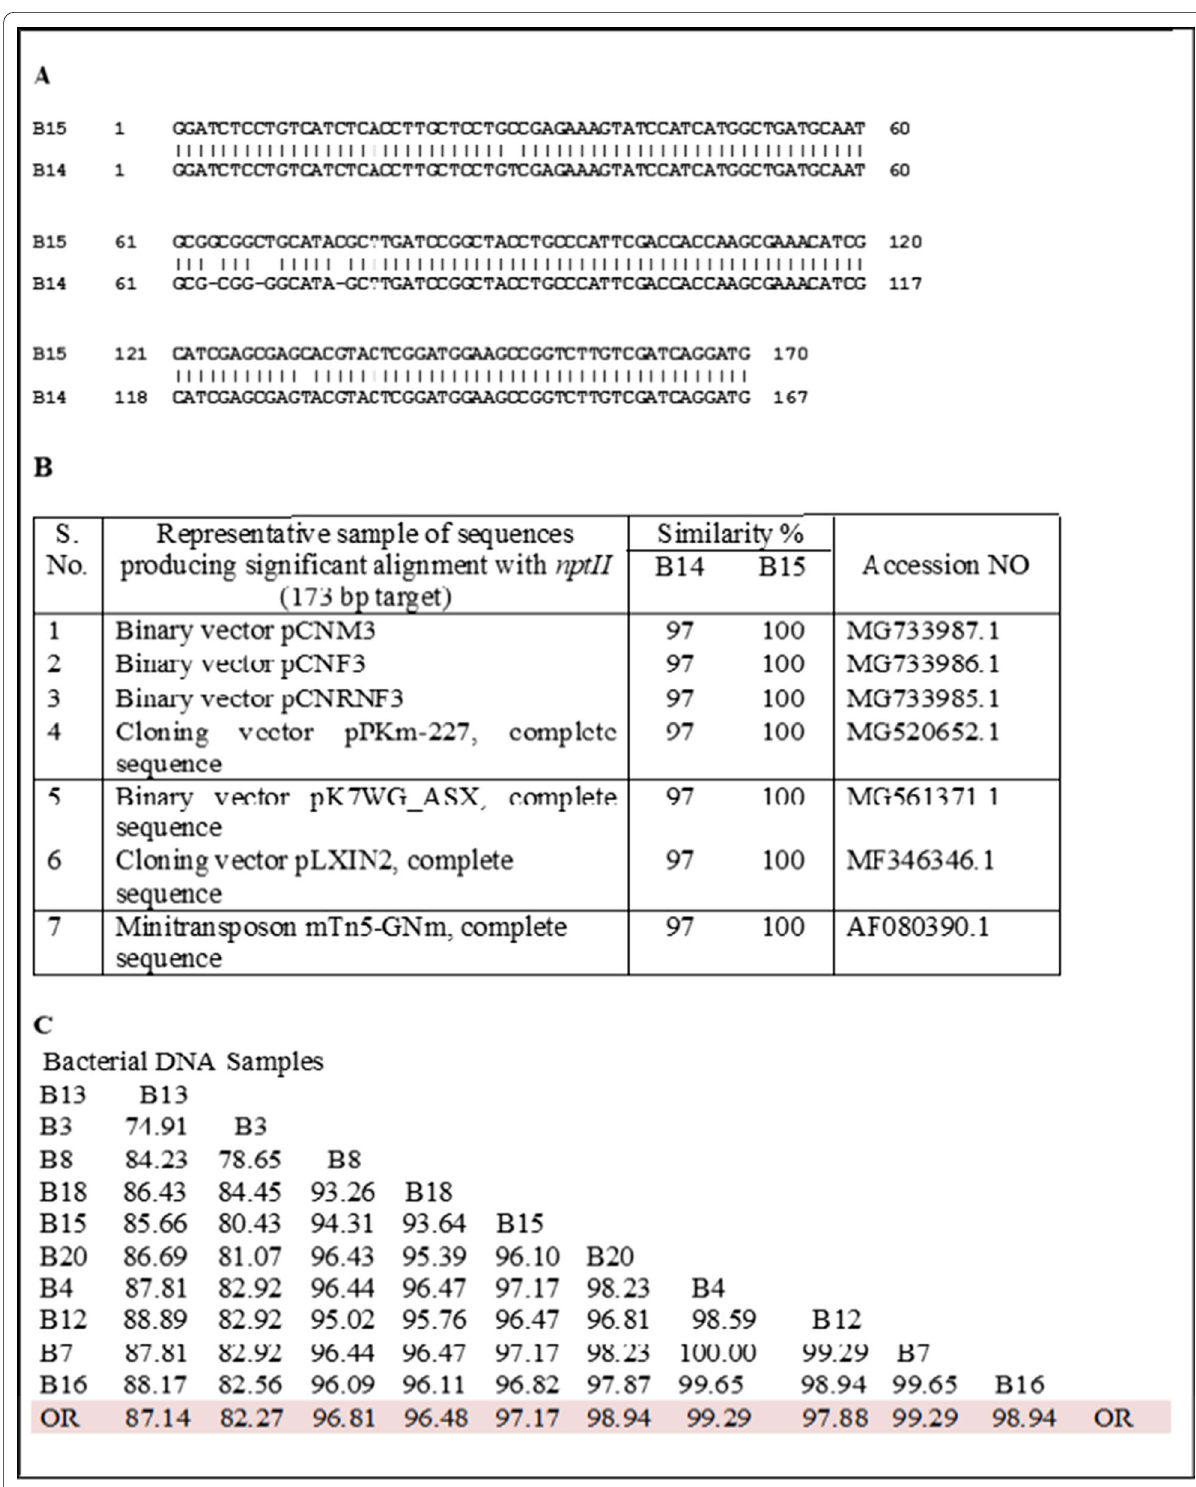
Fig. 2 The internal nucleotide sequencing (for nptII and aadA amplimers), alignment and Blast analysis with gene bank. A Alignment of the internal nucleotide sequences of the amplified nptII in DNA of two of the microflora samples (B14 and B15) from GIT of rats fed on GM‑diet for 90 days. B Variable similarities percentages of number of sequences that produced significant alignment with nptII in the two bacterial samples B14 and B15. C Percent Identity Matrix created by Clustal 2.1 for the internal nucleotide sequences of the PCR amplicons obtained from the amplification of primers for aadA gene in number of bacterial cells. OR is the original reference sequence of the corresponding segment of aadA